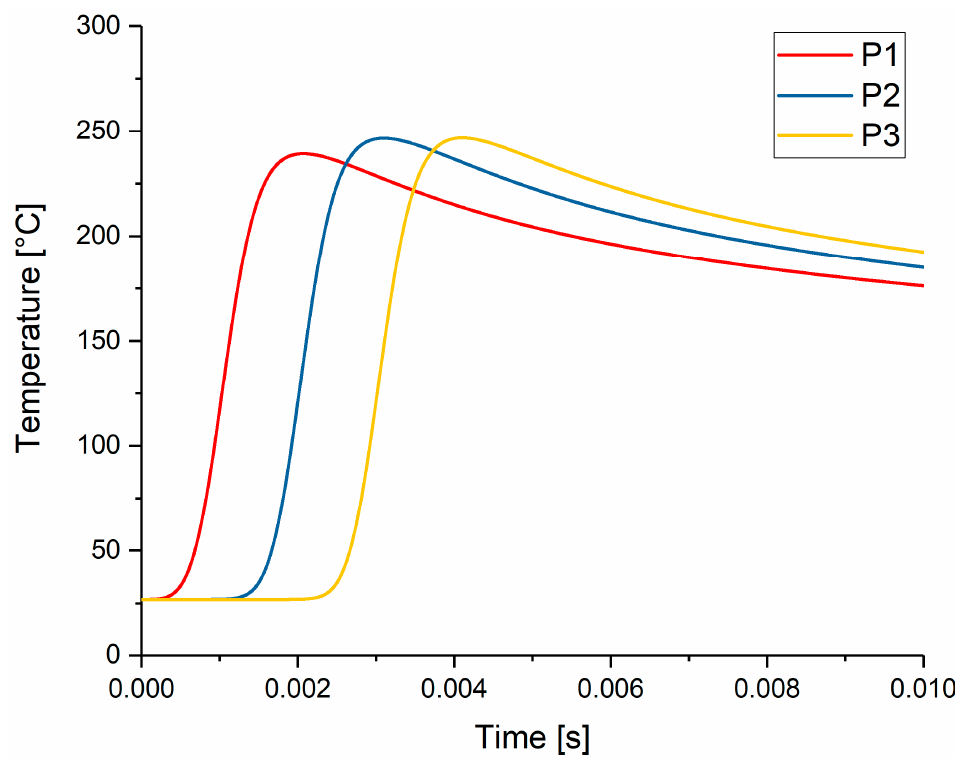
Figure 16. Time–temperature history for the three temperature probes, P1–P3, without solder and silicon.